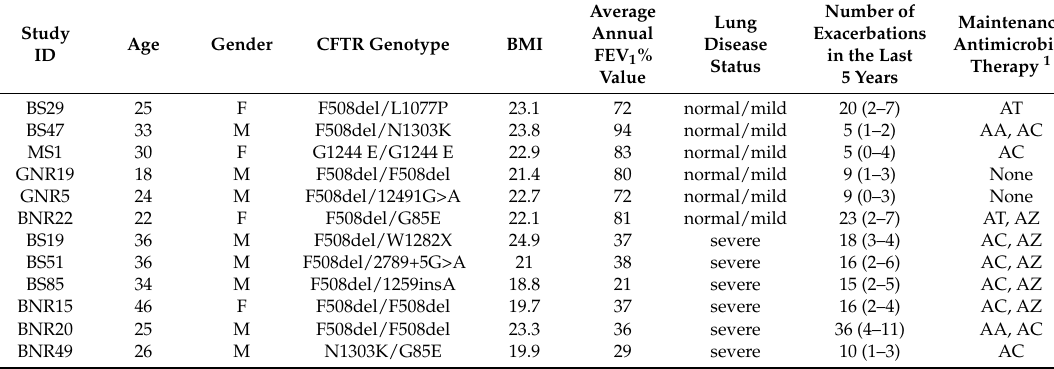
Table 1. Demographic and clinical characteristics of patients with normal/mild (Forced expiratory